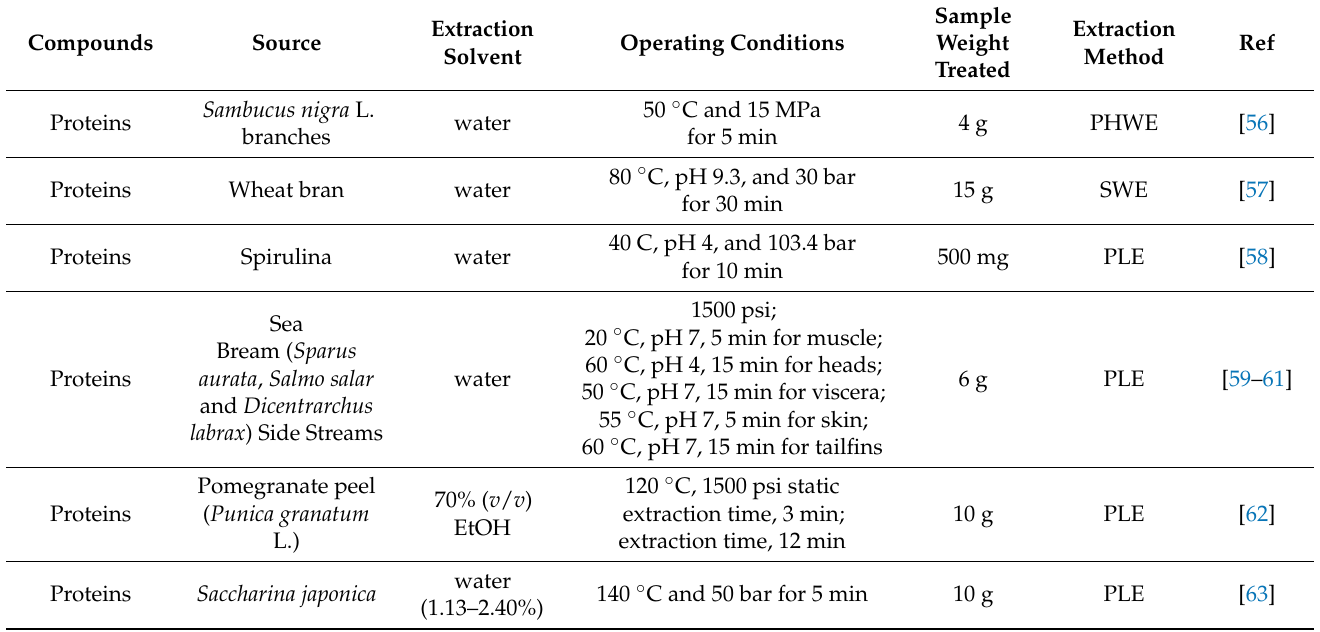
Table 1. Example for extraction of biocompounds with pressurized extraction. EtOH = ethanol; PWE = Pressurized water extraction; PHWE = Pressurized hot water extraction; SWE = Subcritical water extraction; AS = Agitation speed; S/L = solid to liquid ratio; HPTE = high- pressure high temperature